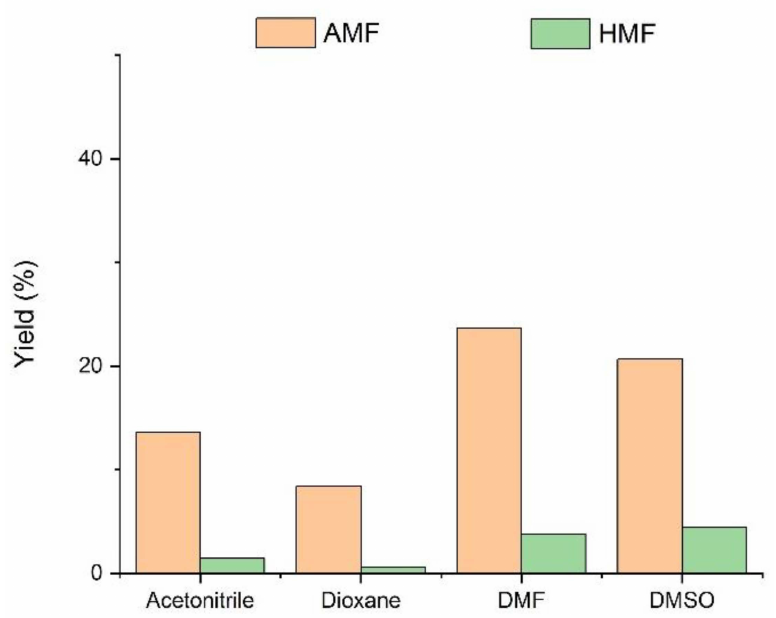
Figure 5. The yield of AMF and HMF after the dehydration of DAF in a single-solvent